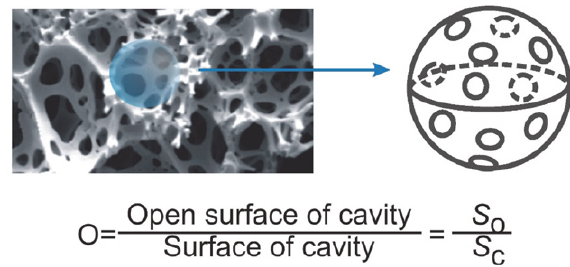
Figure 4 : Interconnectivity of porous structure in polyHIPEs